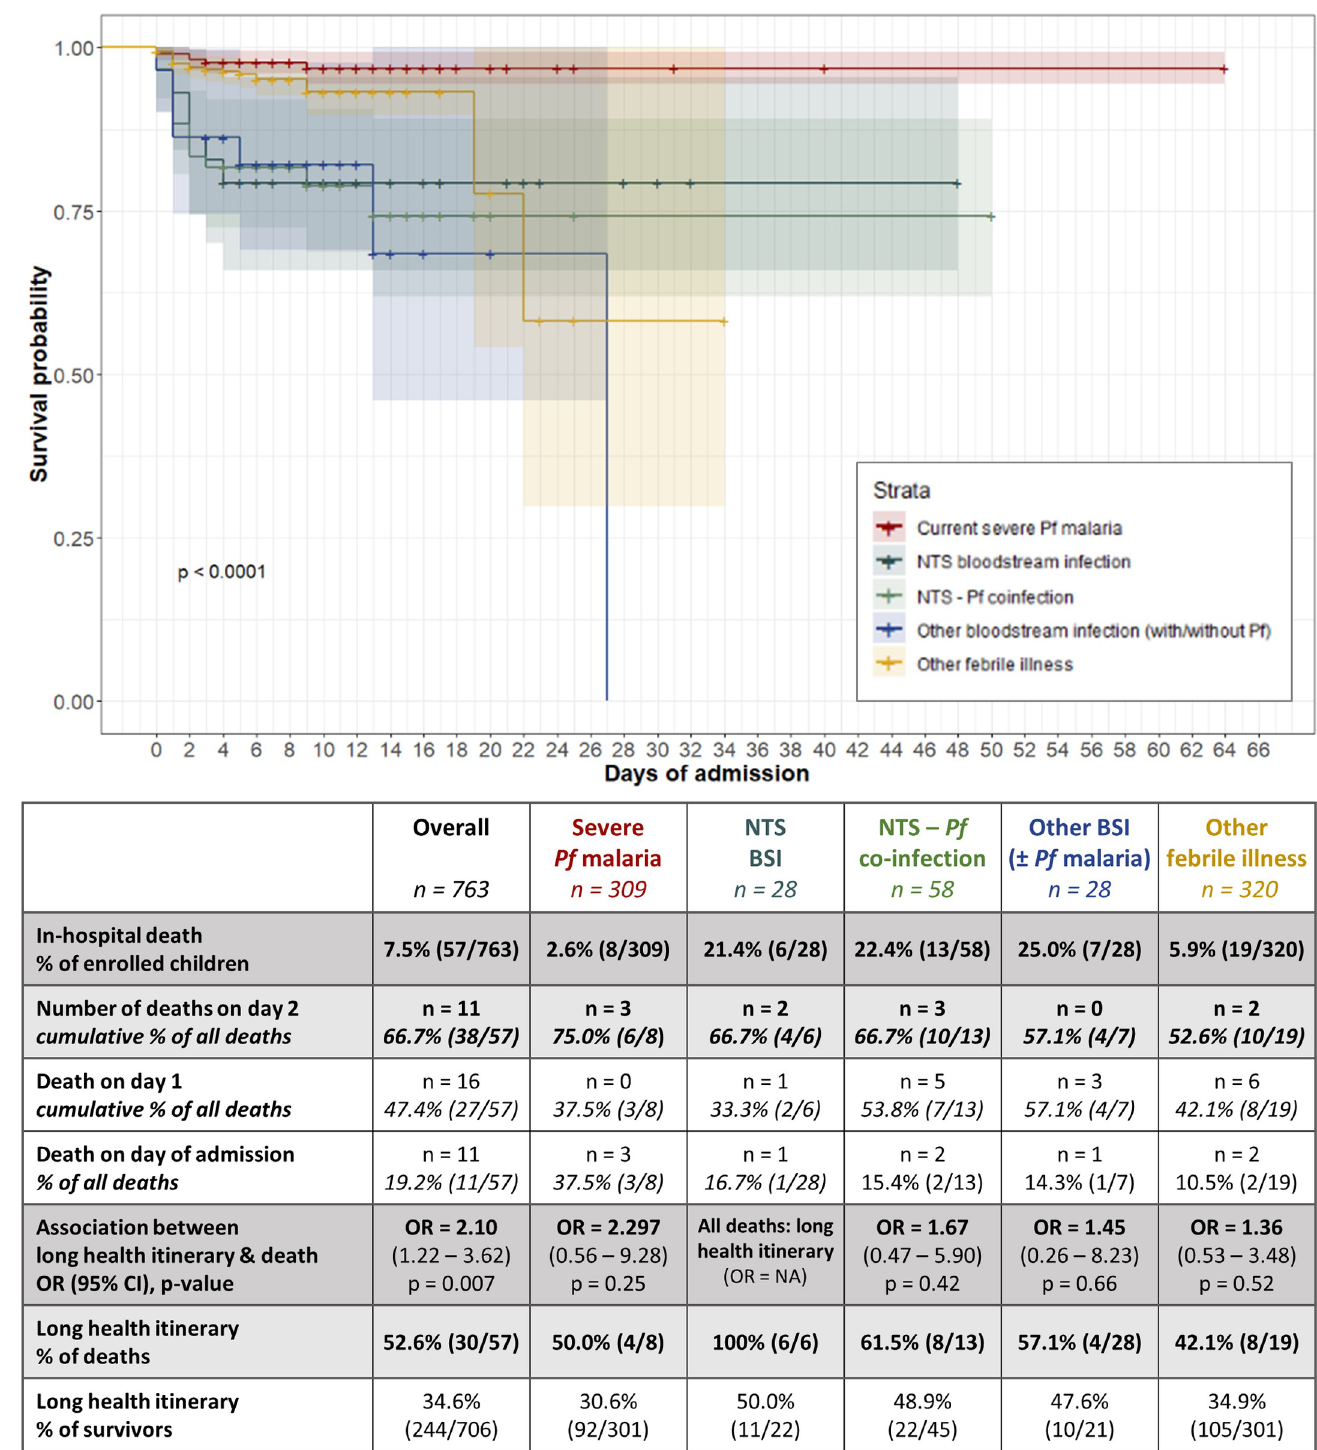
Fig 6. In-hospital survival and association with long health itinerary of children under-five admitted with suspicion of a bloodstream infection according to diagnostic strata. Twenty-one children were lost to follow-up due to hospital evasion or in-hospital referral: they were enrolled in the Kaplan-Meier curve but excluded from analysis in the table. In addition, 20 children with missing microscopy or blood culture data were excluded from the stratified analysis. Odds ratio’s and p-values were calculated with logistic regression. Abbreviations: BSI: bloodstream infection; NTS: non-typhoidal Salmonella; Pf : Plasmodium falciparum .